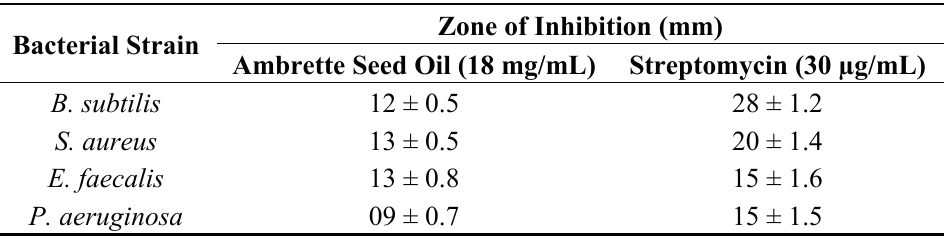
Table 2. Antibacterial activity of ambrette seed oil and streptomycin against bacteria in Mueller Hinton agar by well diffusion